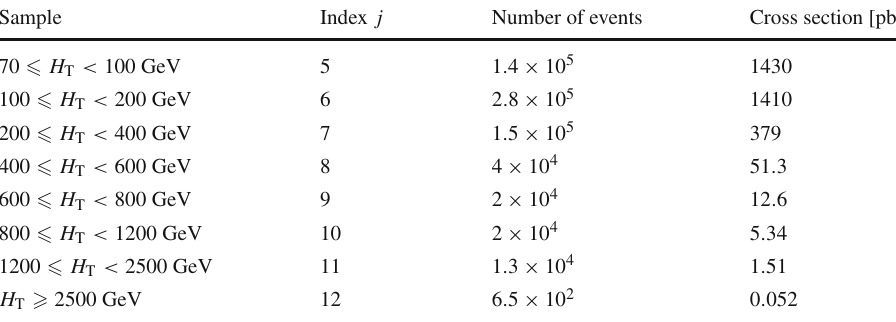
Table 4 Number of events in the W+jets samples produced in ranges in H T and corresponding cross sections